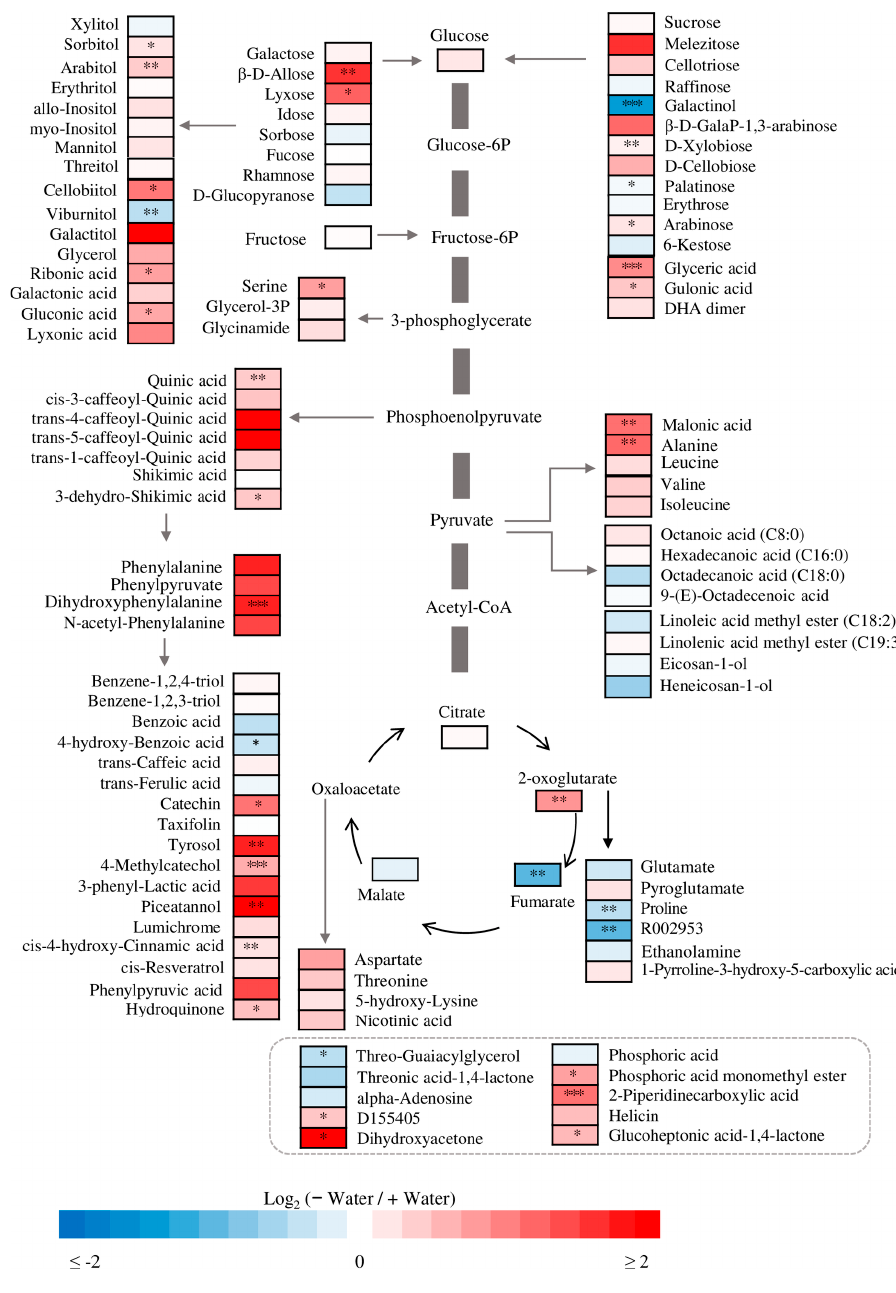
Figure 8. Changes (log 2 sufficient water/limited water) of low molecular weight metabolites in leaves of Alnus glutinosa grown under sufficient (+ water) and limited ( − water) water conditions. *, **, and *** indicate significant differences between trees with sufficient and limited water supply at p < 0.05, 0.01, and 0.001, respectively. R002953 and D155405 are codes of N-methyl trans-4-hydroxy-L-proline (2S,4R)-4-hydroxy-1-methyl pyrrolidine-2-carboxylic acid and an unknown metabolite, respectively, in Golm library.